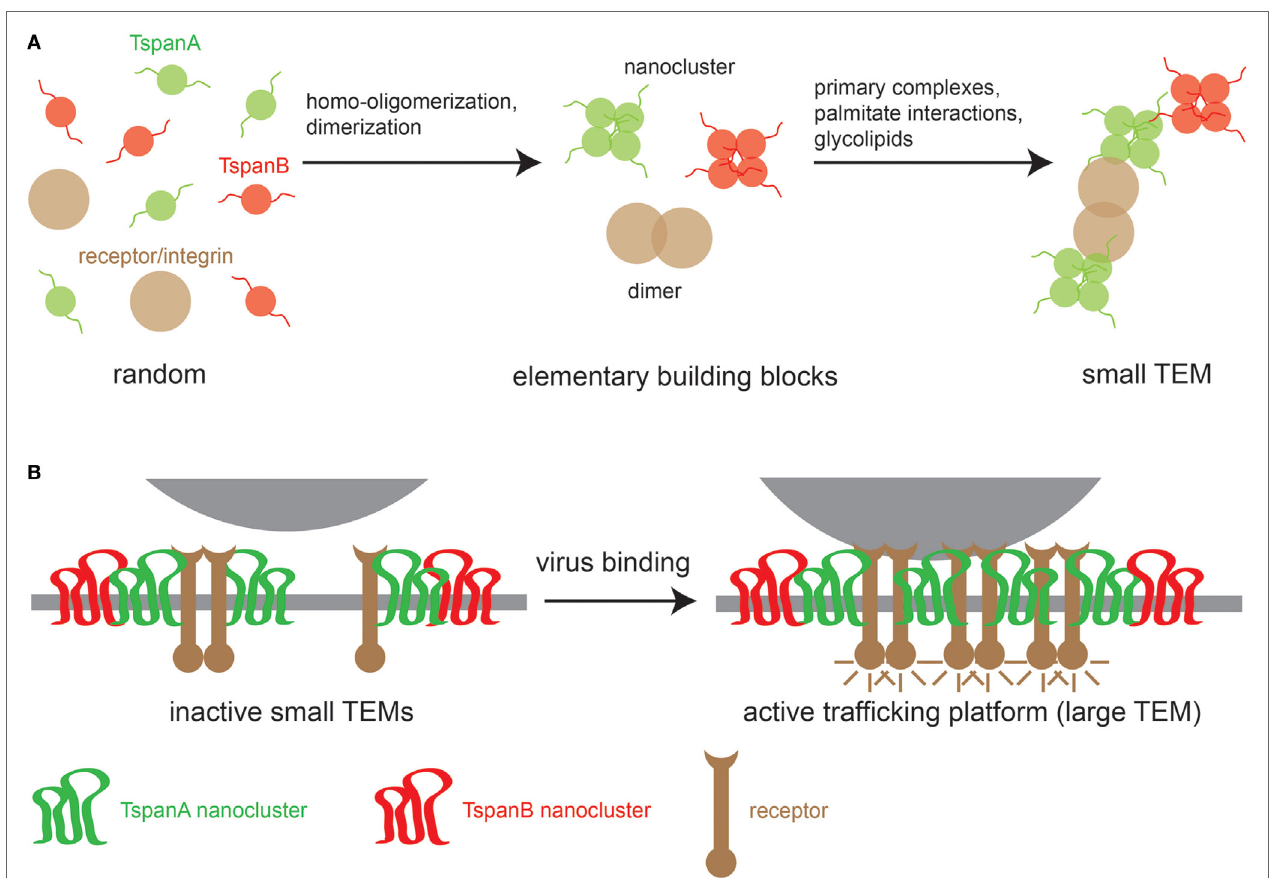
FigURe 1 | Model of TEM building. (A) Left, random distribution of three TEM components: two tetraspanins (TspanA and TspanB) and a primary interaction partner of TspanA [e.g., an integrin or a growth factor receptor (GFR)]. Middle, TEM building blocks; tetraspanins (Tspans) are arranged in homomeric nanoclusters and integrins/GFRs form dimers. Right, building blocks are connected via strong specific interactions between TspanA and the receptor/integrin dimer and weak nonspecific interactions between different Tspan nanoclusters. (B) When a virus encounters the cellular membrane, virus surface molecules crosslink small TEMs to form larger TEMs, thereby concentrating proteins leading to the activation of intracellular signaling cascades that trigger the uptake of the Tspan trafficking